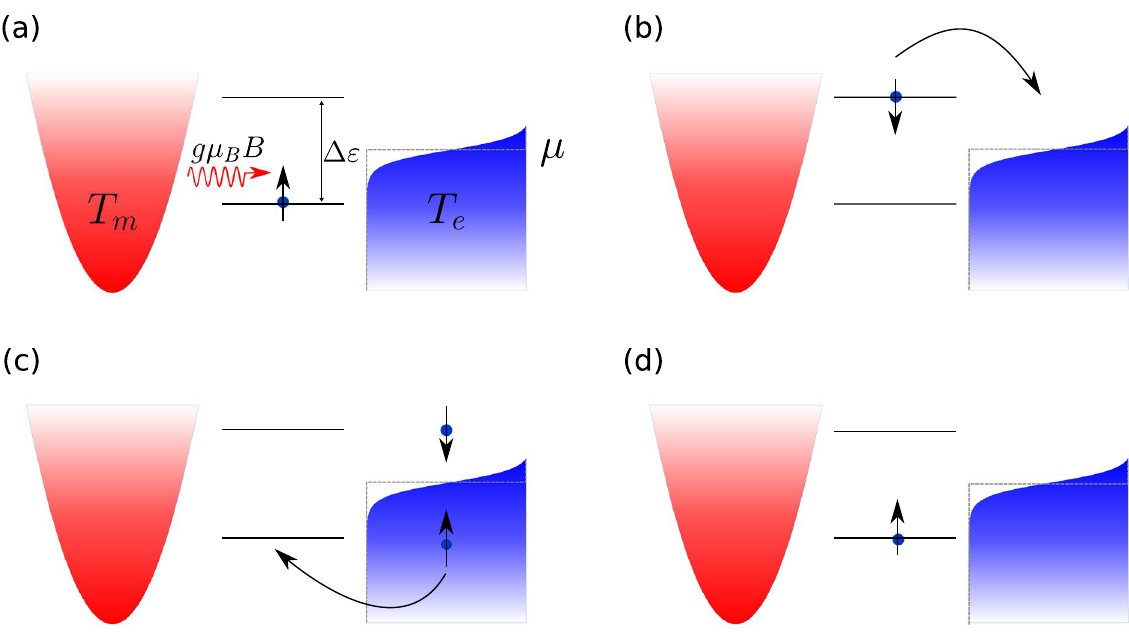
Figure 1. Schematic picture showing the idea of converting magnon current to electron spin current by means of temperature difference. The red parabola symbolizes the magnon reservoir, whereas blue curve stands for density of electrons in the metallic lead. The blue area below the curve denotes states occupied by electrons and the white space above the curve are empty states. Furthermore, red color is associated with higher temperature than blue one, i.e. T m > T e . Zeeman split dot’s energy level is depicted by two black solid horizontal lines. The ε ε g µ B B . Magnon, carrying energy g µ B B , is depicted as red splitting of dot’s energy level equals �ε = ↓ − ↑ = wavy arrow, whereas blue dot with vertical arrow denotes an electron with a given